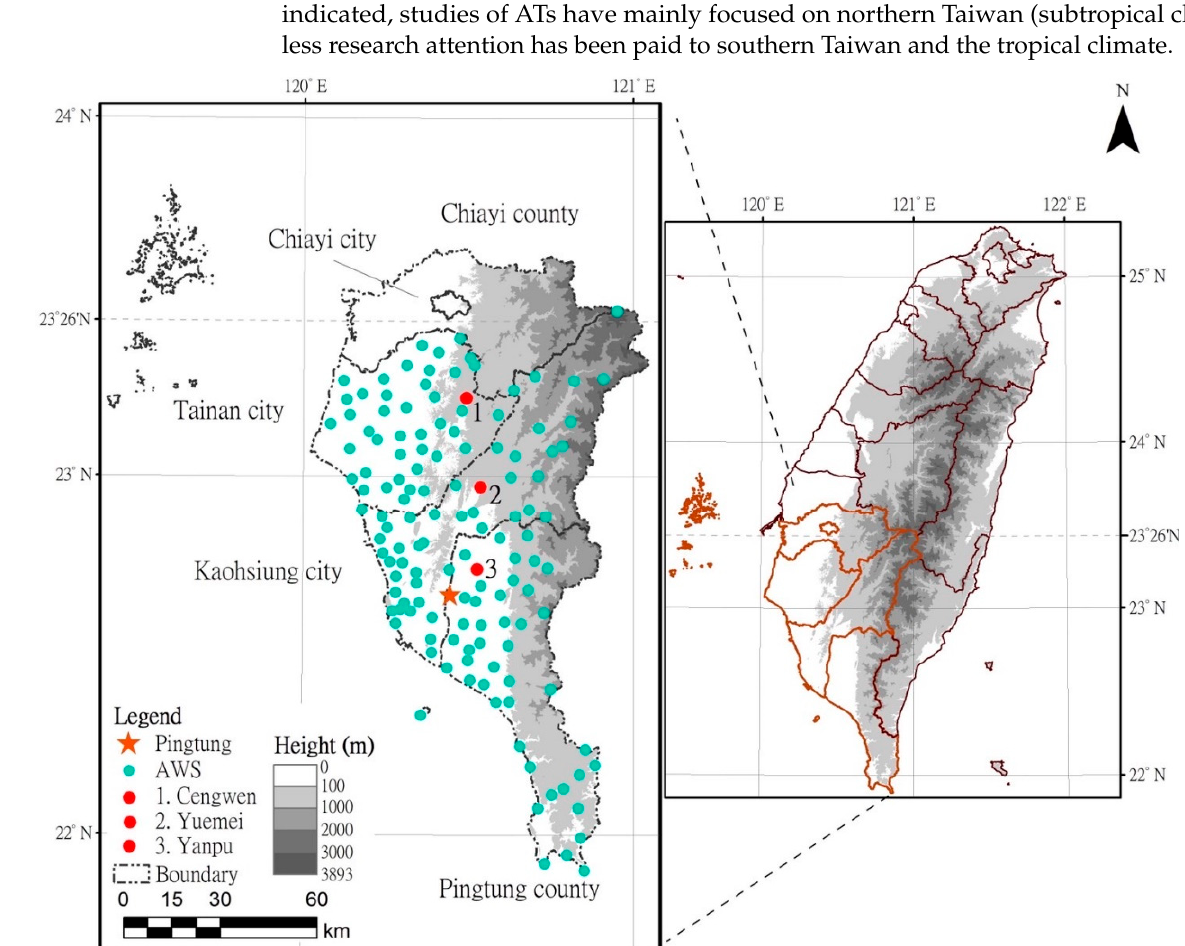
Figure 1. The locations of 134 AWSs (green dots) used in this study. Variables of Pingtung meteorological station located at the Pingtung Airport (red star), and three AWSs of Cengwen (station 1, red dot), Yuemei (station 2, red dot), and Yanpu (station 3, red dot) were used to describe the background conditions of the event day.